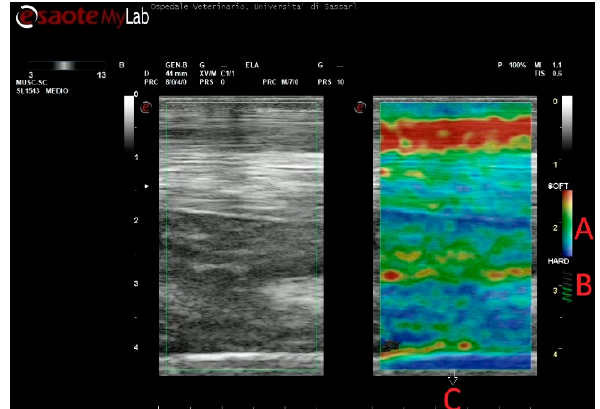
Figure 1. Example of strain elastography. ( A ) Color range selected, ( B ) Indicator for correct compression, ( C ) Field of view.